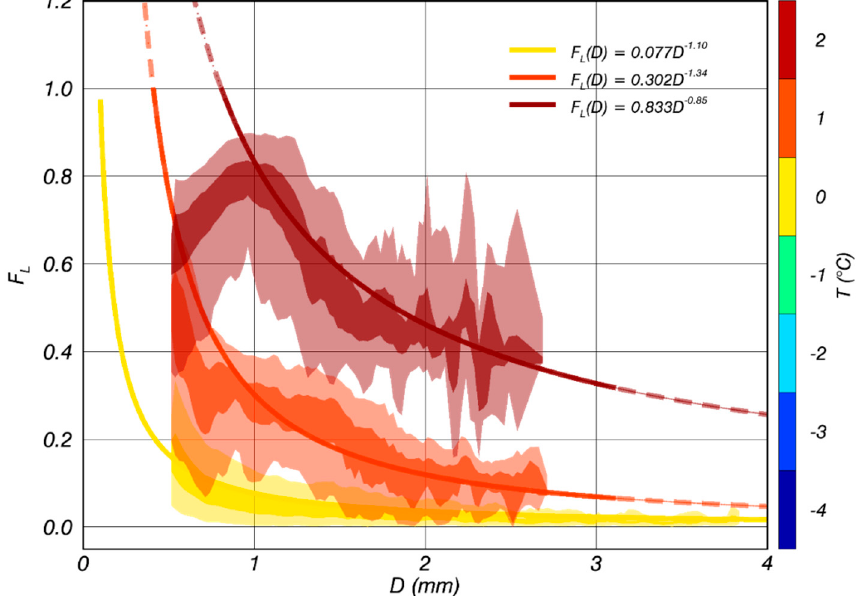
Figure 7. Color − shaded 2D histogram plots of F L versus D for each T class. The color shades correspond to the data range of ±10% and ±25% from the median value.